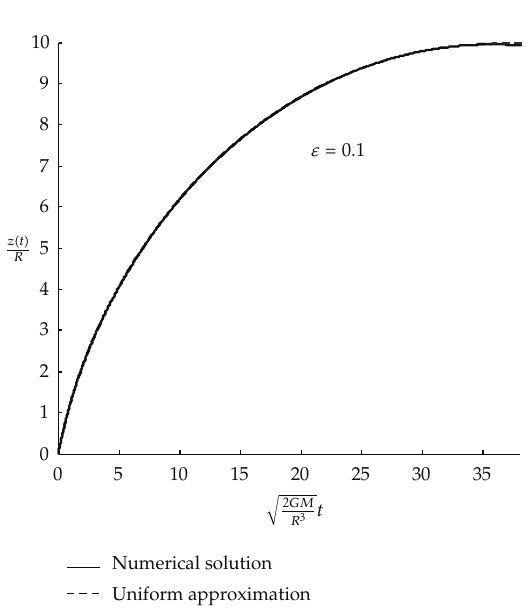
Figure 6: The function z (cid:4) t (cid:5) in the first quarter period of the orbit, with ε (cid:7) 0 . 1, solid line corresponds to numerical integration of (cid:4) 3.1 (cid:5) , the dashed line represents the uniform approximation.